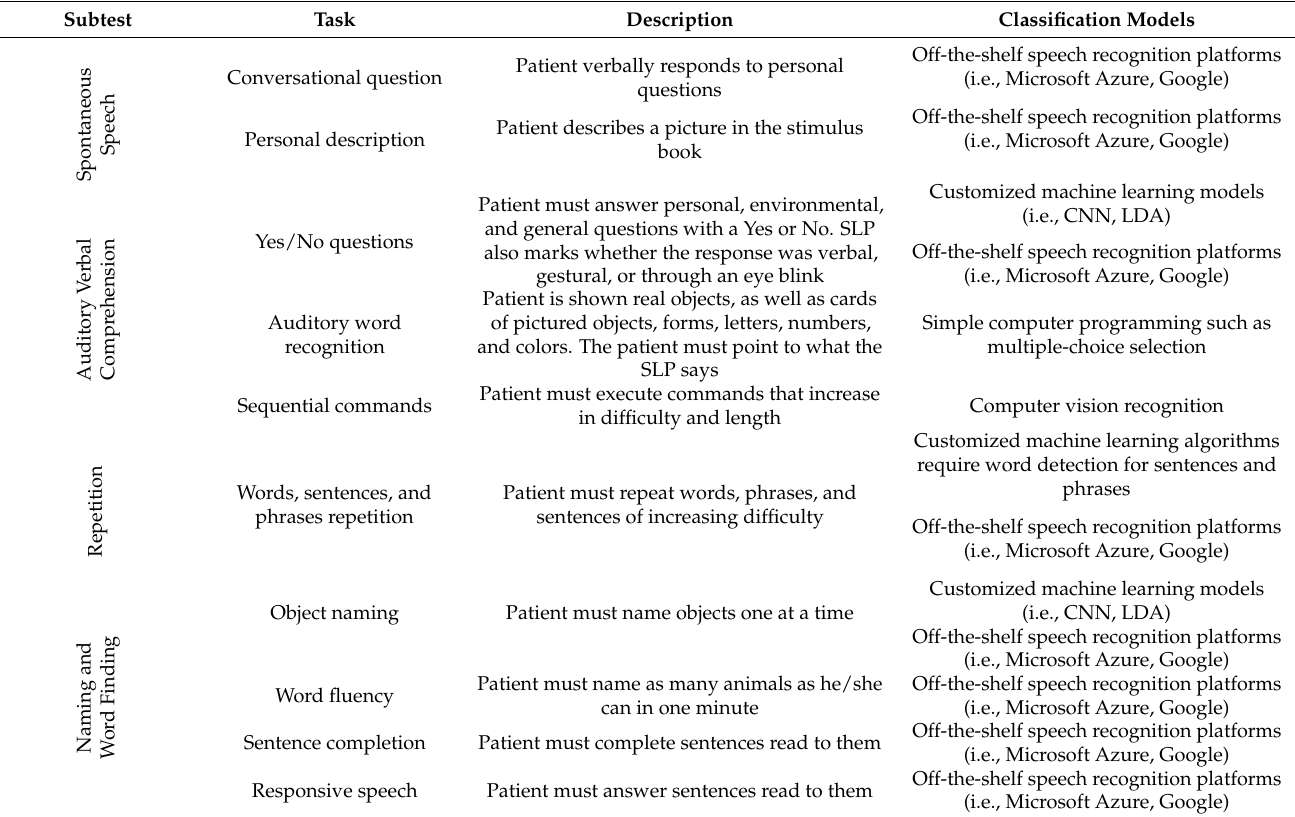
Table 2. Batteries’ key subtests and suitability of classification